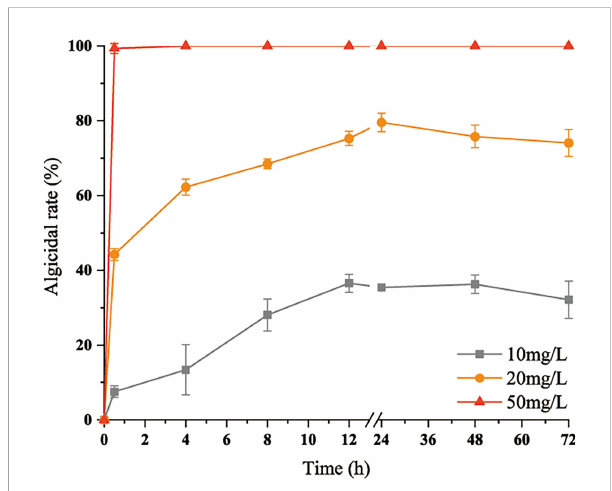
FIGURE 3 Variations in inhibitory rates of the algicidal substances with time. Three replicates were used for error bars (representing the standard